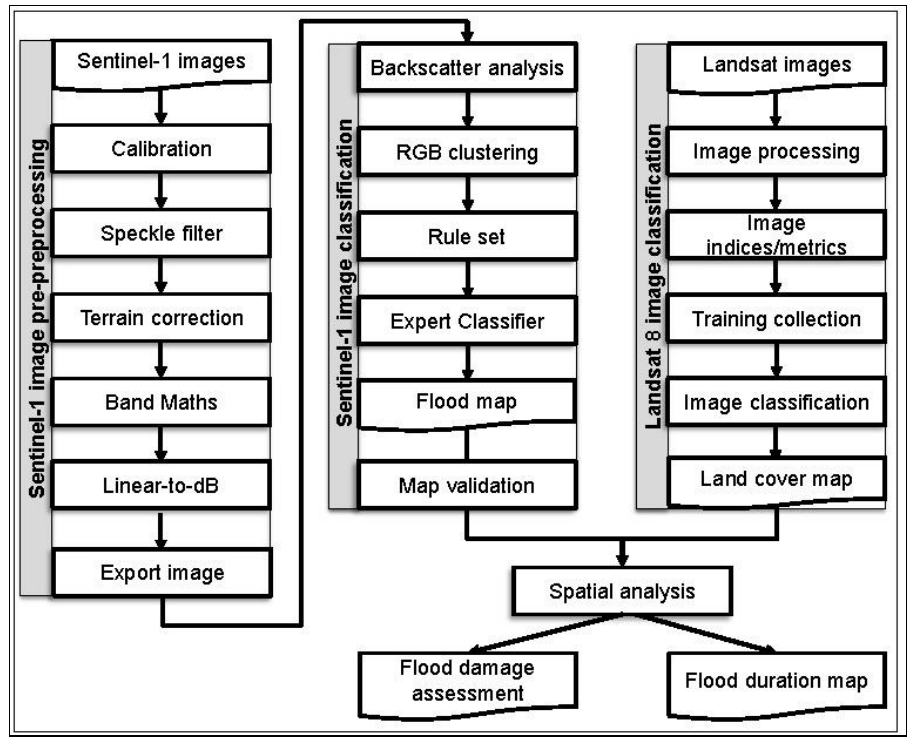
Figure 3. Overall methodological framework for the flood inundation mapping and damage assessment using multi-temporal Sentinel-1 and Landsat-8 satellite images.